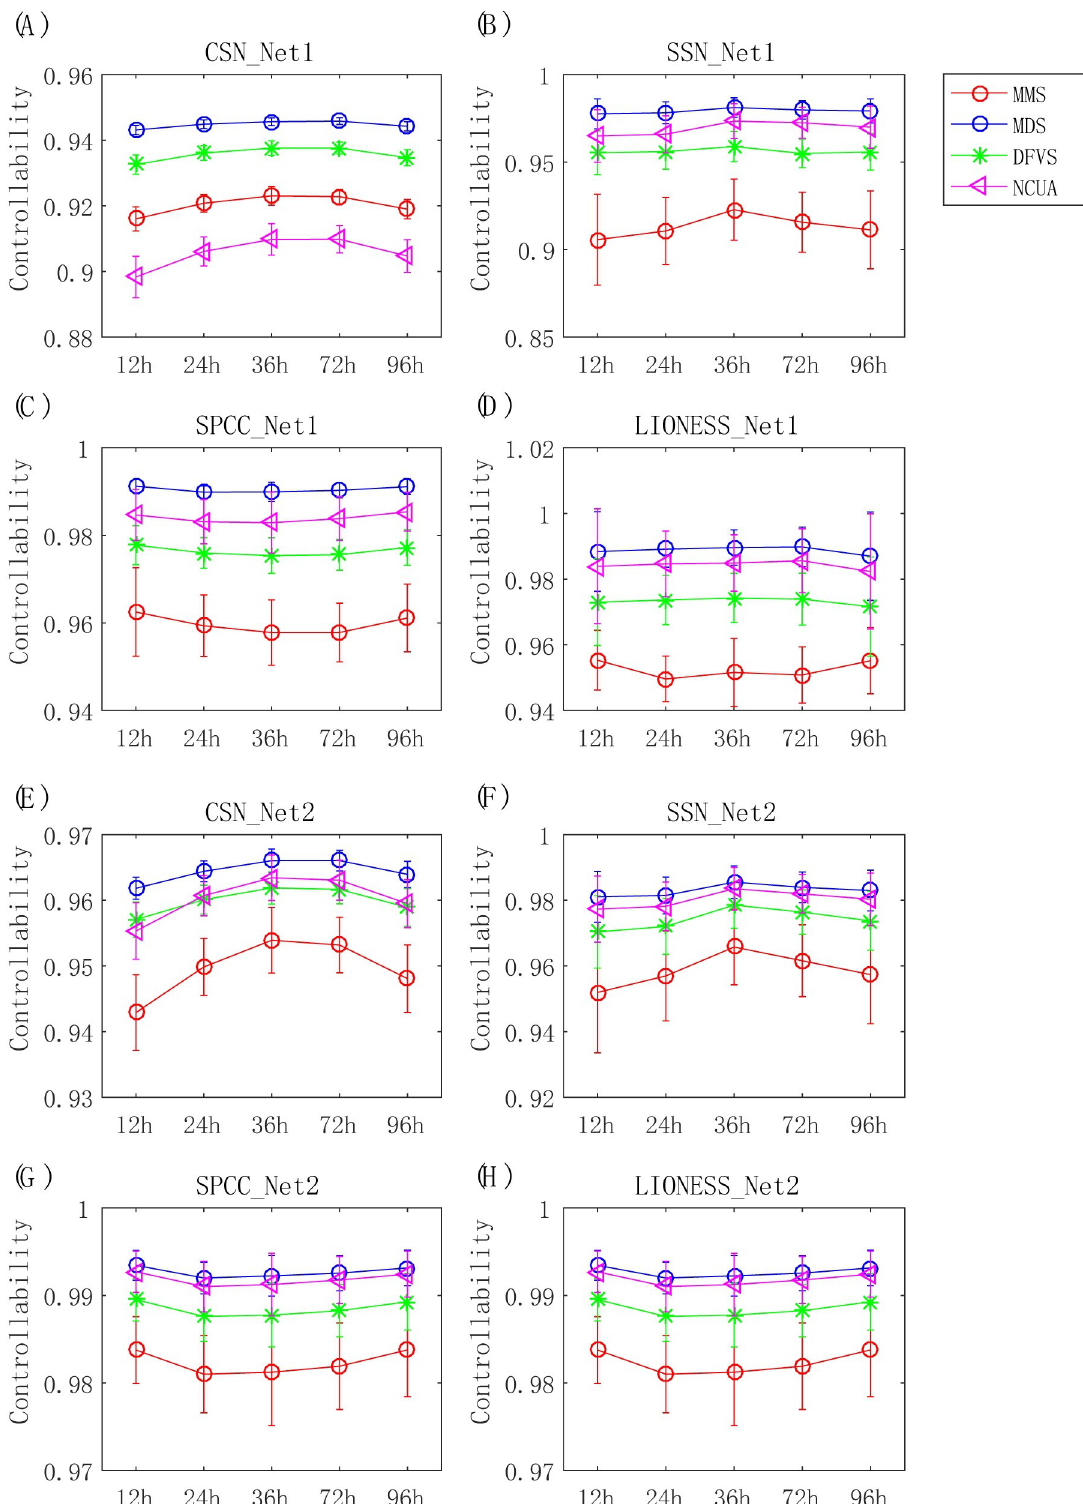
Fig 6. Evaluation of SSC workflows by the identification of important genes involved in cell fate decisions. The corresponding SSC analysis dependent on different sample-specific state transition networks, including (A) CSN_Net1, (B) SSN_Net1, (C) SPCC_Net1, (D) LIONESS_Net1, (E) CSN_Net2, (F) SSN_Net2, (G) SPCC_net2, and (H) LIONESS_Net2.